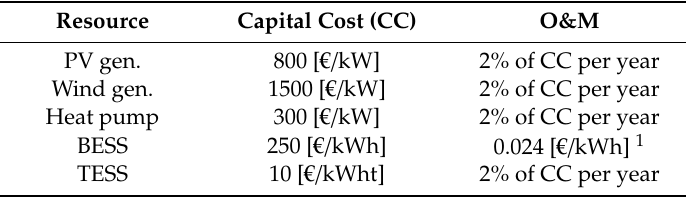
Table 1. Main economic parameters used for tests.